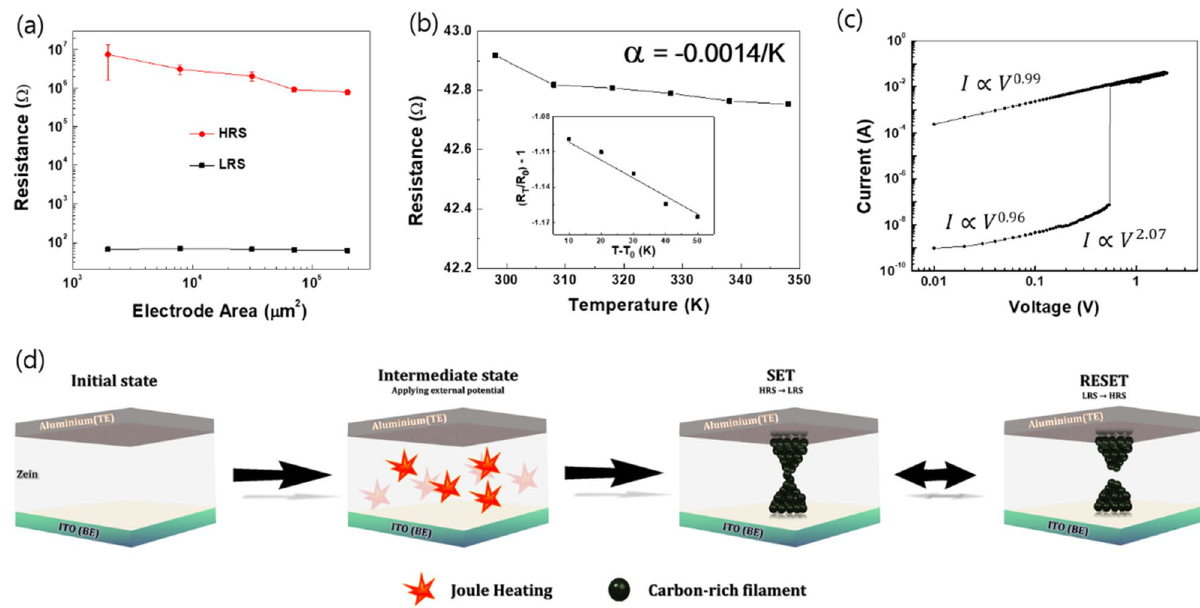
Figure 4. ( a ) Electrode-area dependence of the zein-based device. ( b ) Variation in the resistance with temperature for the zein-based device. The inset shows the temperature coefficient of resistance in the LRS. ( c ) Double logarithmic plot in a positive sweep region from the high resistance state to the low resistance state. ( d ) Schematic illustration of the switching mechanism for the device with the Al/zein/ITO structure. When an external bias is applied to the device, pyrolysis in the zein active layer begins due to Joule heating. Consequently, a conductive carbon-rich filament is formed between the Al top electrode and the ITO bottom electrode. The carbon-rich filament can be ruptured by thermal driving due to an applied negative